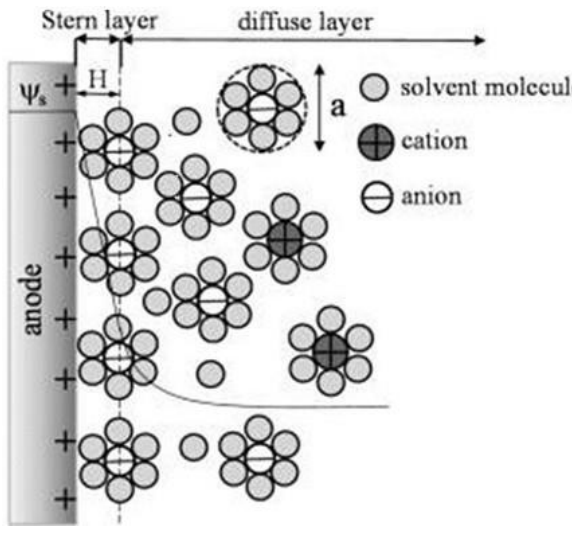
Figure 2. Schematic of the electric double layer structure showing the arrangement of solvated ani- ons and cations near the electrode/electrolyte interface in the Stern layer and the diffuse layer of Gouy – Chapman – Stern model. Reprinted with permission from Ref. [75]. Copyright © 2022, Amer- ican Chemical Society.